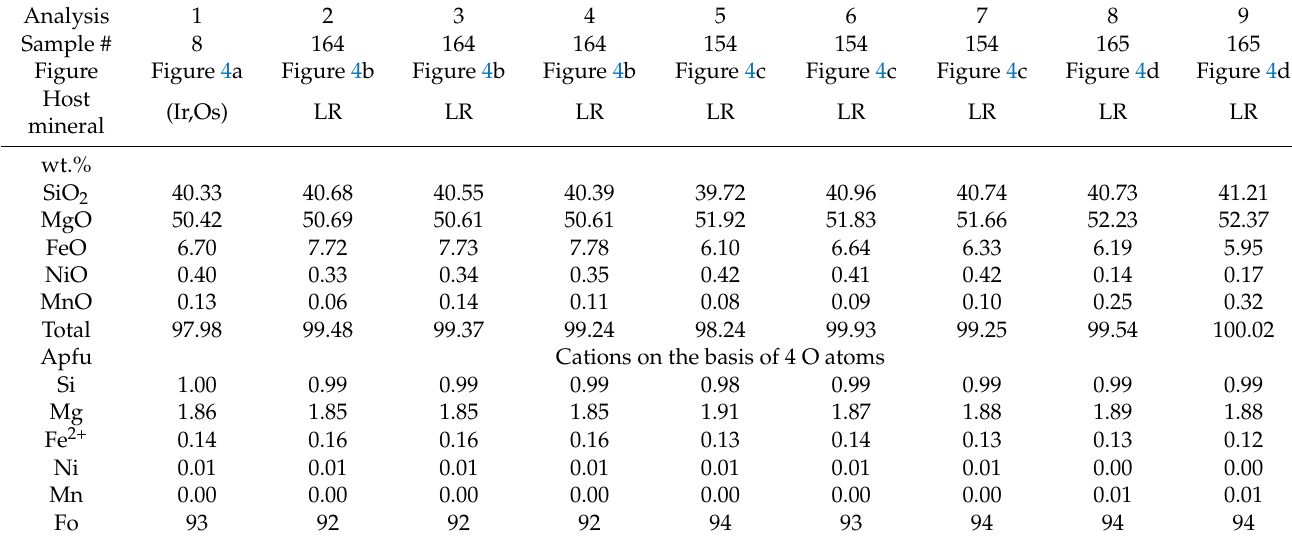
Table 3. Electron microprobe analyses of high-Mg olivine inclusions in osmian iridium and Ru-Os sulfides from primary PGM assemblage of the Verkh-Neivinsk massif.